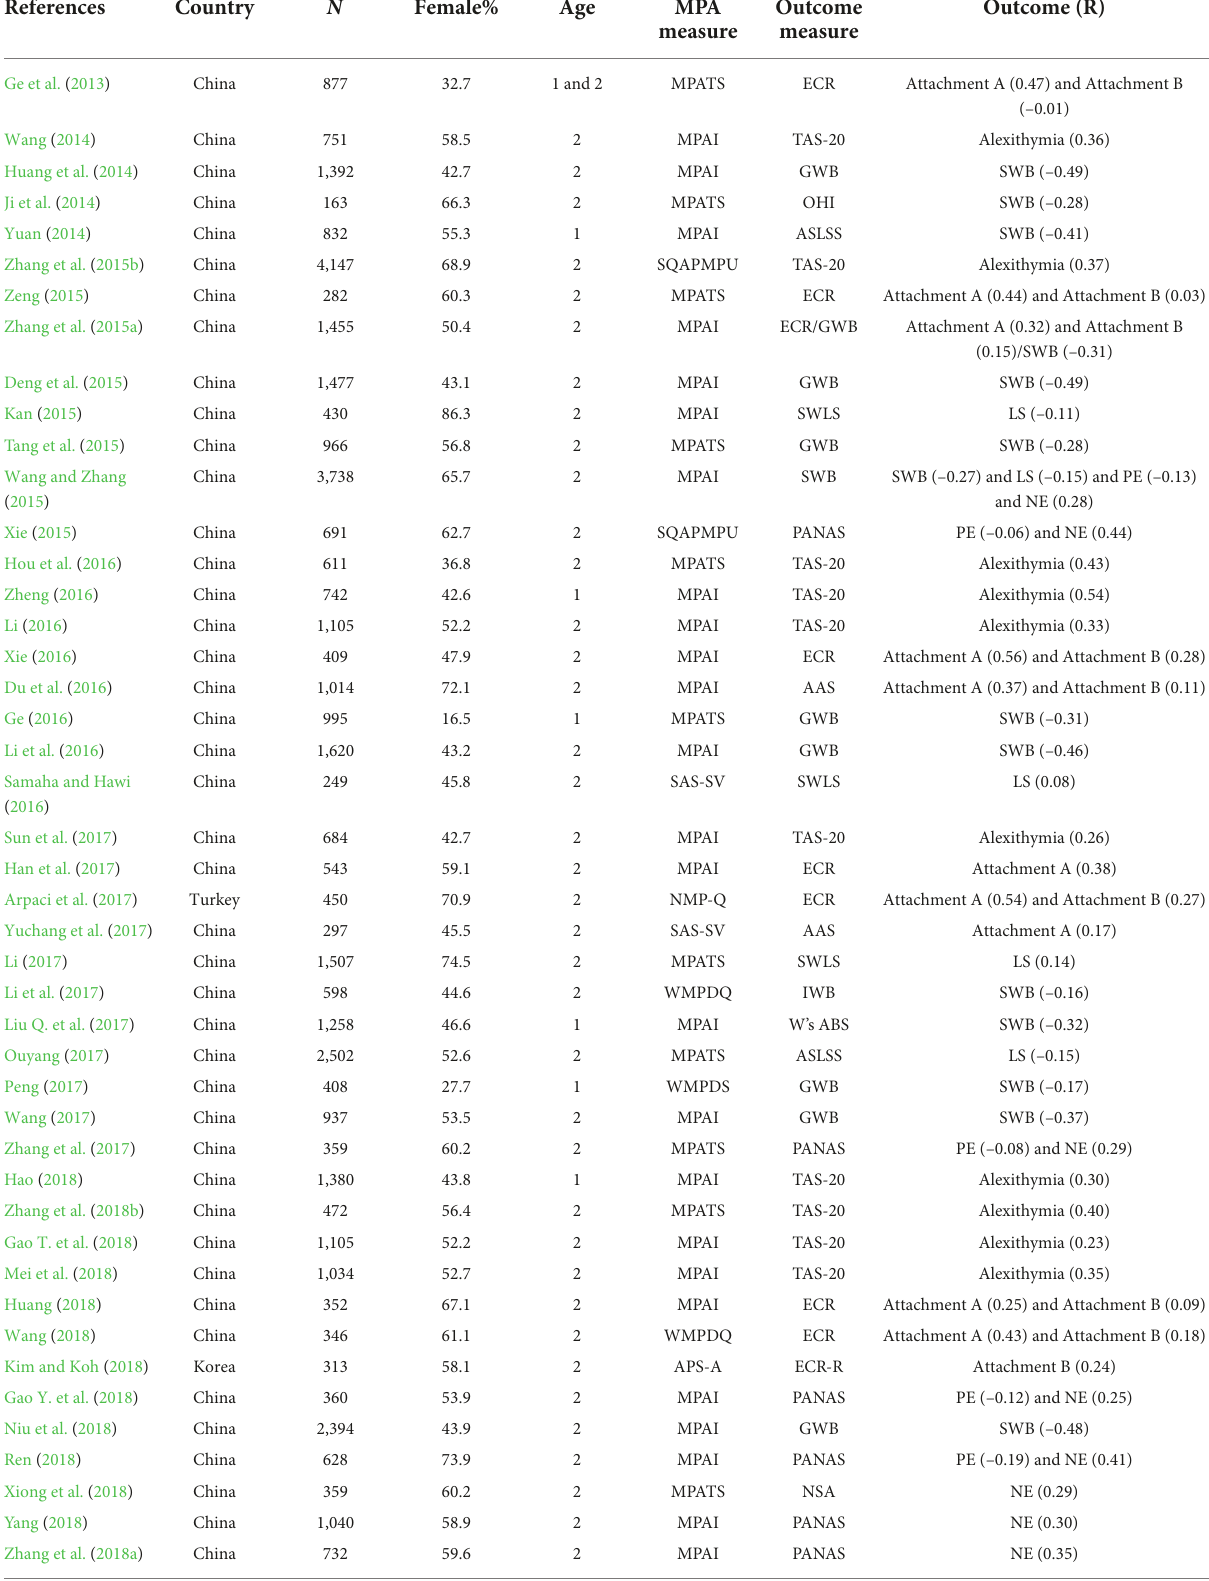
TABLE 1 Characteristics of the 110 studies included in the